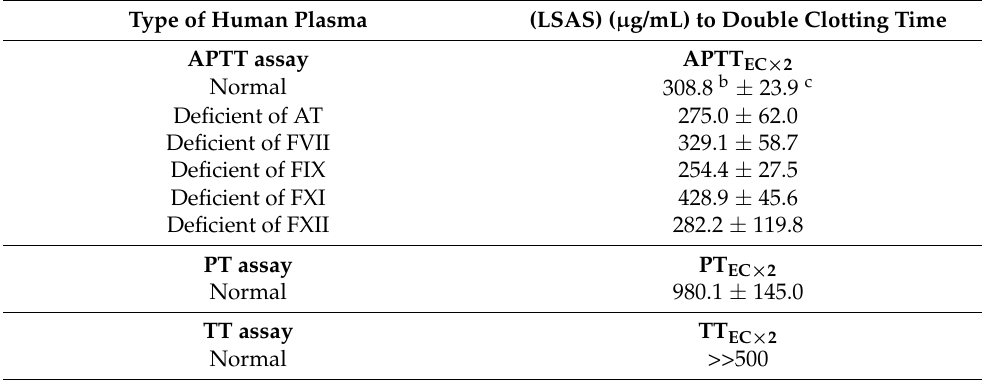
Figure 2. ( A ) The effect of LSAS on the APTT of normal human plasma and human plasmas deficient of antithrombin (AT), FVII, FIX, FXI, or FXII. ( B ) The effects of LSAS on the APTT (intrinsic pathway), PT (extrinsic pathway), and TT (thrombin-induced clotting) of normal human plasma. ( C ) The APTT profile of FXI-deficient human plasma following the addition of 2.6 nM or 5.2 nM, in the presence ( or absence ( • ) of LSAS. ( D ) The inhibition profile of human FXIa by LSAS, as spectrophotometrically Table 1. The effect of LSAS on the clotting times (APTT, PT, and TT) of different human plasmas a .